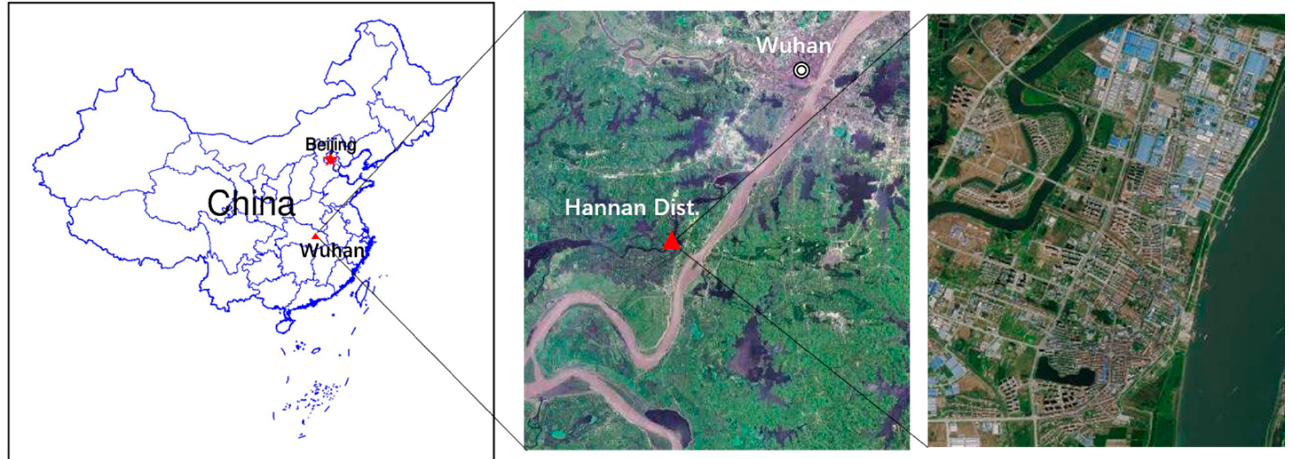
Figure 1. Location of the test field.